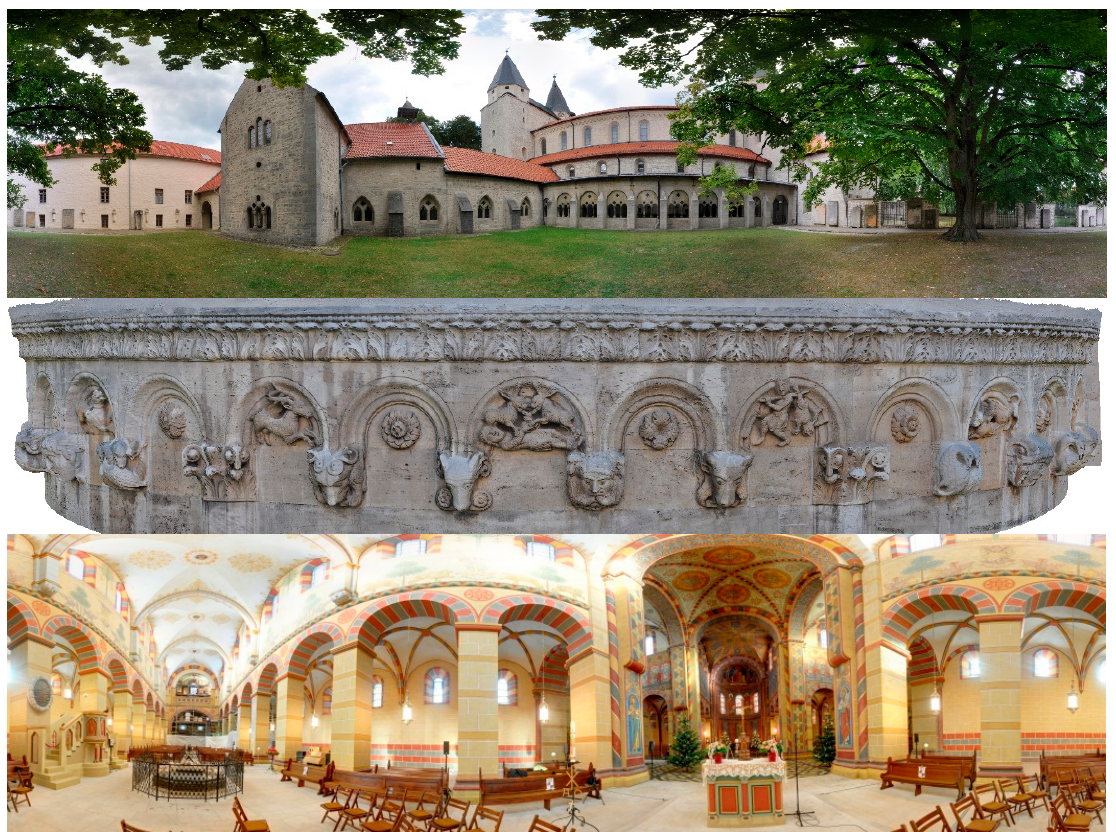
Figure 1. Panoramic view of the Imperial Cathedral in Königslutter, Germany ( top ), the hunting frieze on the external wall of the main apsis of the cathedral with story-telling figures ( centre ), and a panoramic view of the interior of the cathedral ( bottom ).